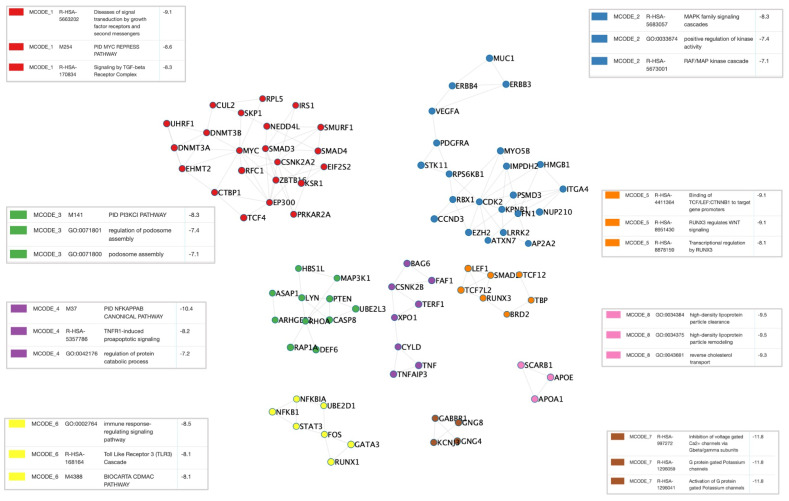
COVID-19 meta-interactome clusters.The M-CODE algorithm was applied to detect densely interconnected node subsets. The network representation displays a different color for each cluster, associated with the enriched biologic processes in the relative boxes.